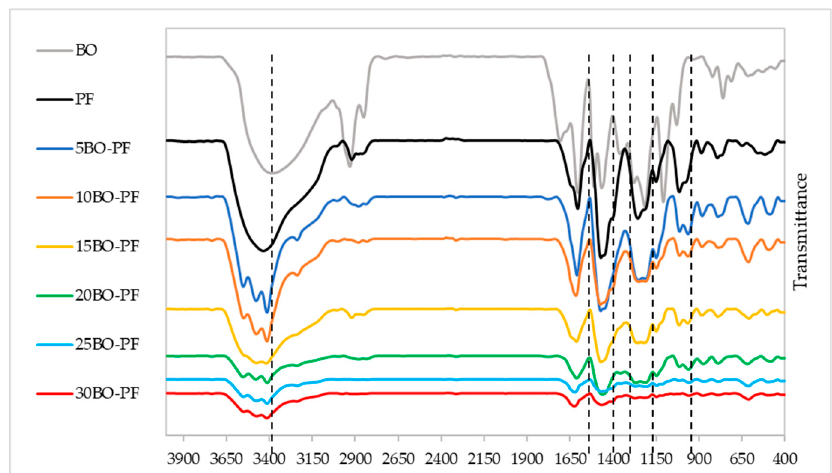
Figure 6. FTIR spectrum of the BO − PF resins from 5 to 30% substitution rate. In contrast to PL − PF resins, an intense peak at around 1030 cm − 1 was observed in BO − PF resins. This peak matches with C-O bonds stretching vibration caused by alcoholic ether groups which may correspond to the aliphatic C–O(Ar), aliphatic C–OH, and methylol C–OH in the syringyl unit of lignin. Peaks at around 1211–1245 cm − 1 which indicates the presence of G-propane units were also observed in BO − PF resins, but they are less intense compared to the PL − PF resins